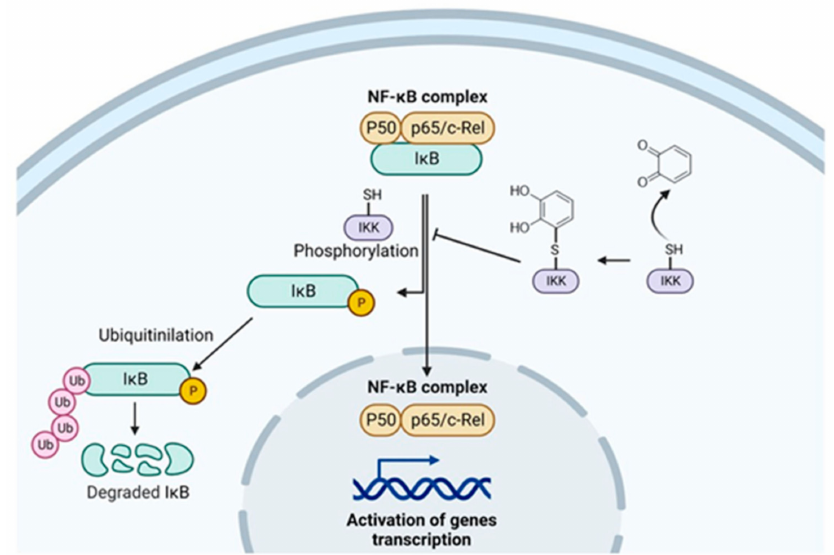
Figure 3. Proposed mechanism of oxidable diphenols on the inhibition of NF- κ B